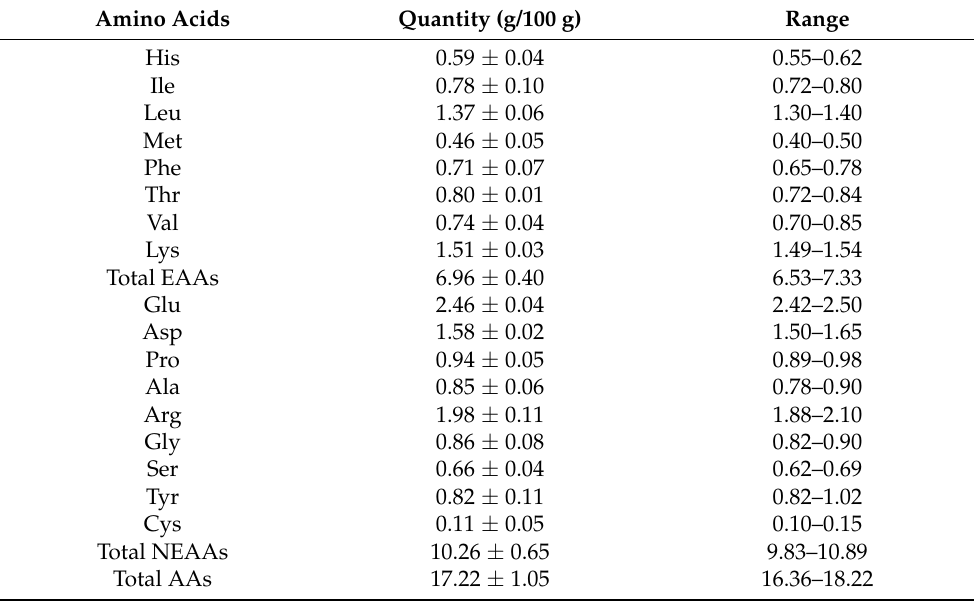
Table 5. Amino Acids profile of spiny-cheek crayfish meat in g/100 g of sample. Amino Acids Quantity (g/100 g) Range His 0.59 ± 0.04 0.55–0.62 Ile 0.78 ± 0.10 0.72–0.80 Leu 1.37 ± 0.06